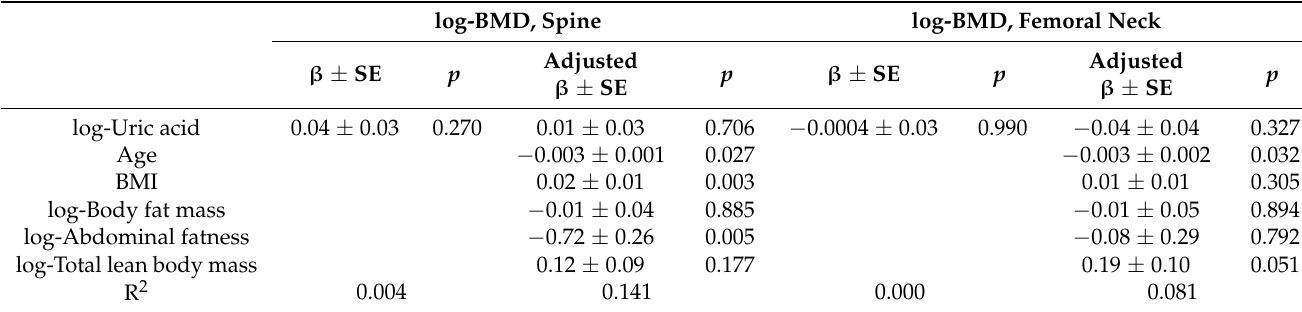
Table 3. Simple, multiple linear regression.